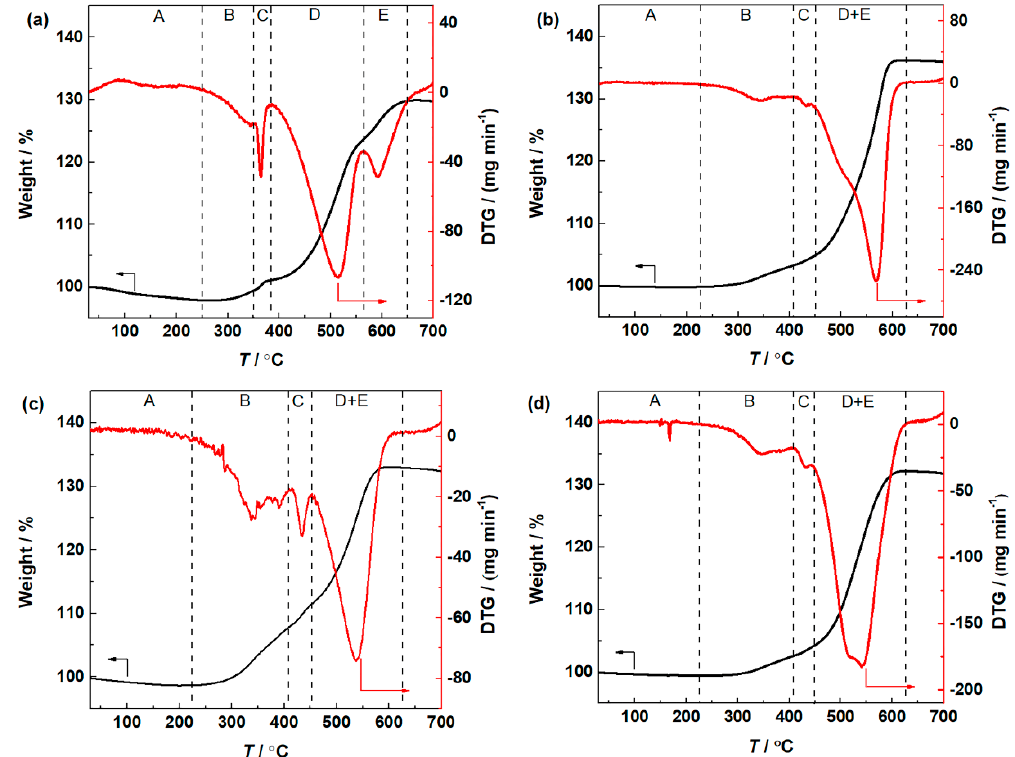
Figure 6. TG curves of ( a ) MC, ( b ) MC-Ni-1, ( c ) MC-Ni-1.5 and ( d ) MC-Ni-2.